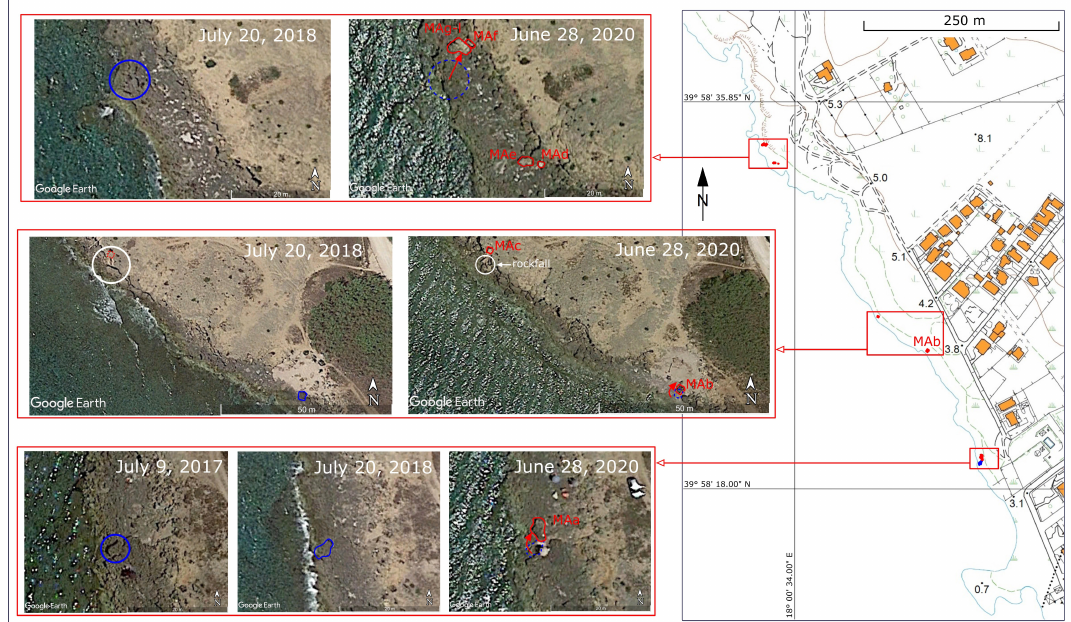
Figure 6. Comparative satellite images of Mancaversa. The initial positions of the boulders are highlighted in blue, the final ones in red; a rockfall are white. Red arrows highlight the displacements. Topography from the technical map of Lecce Province